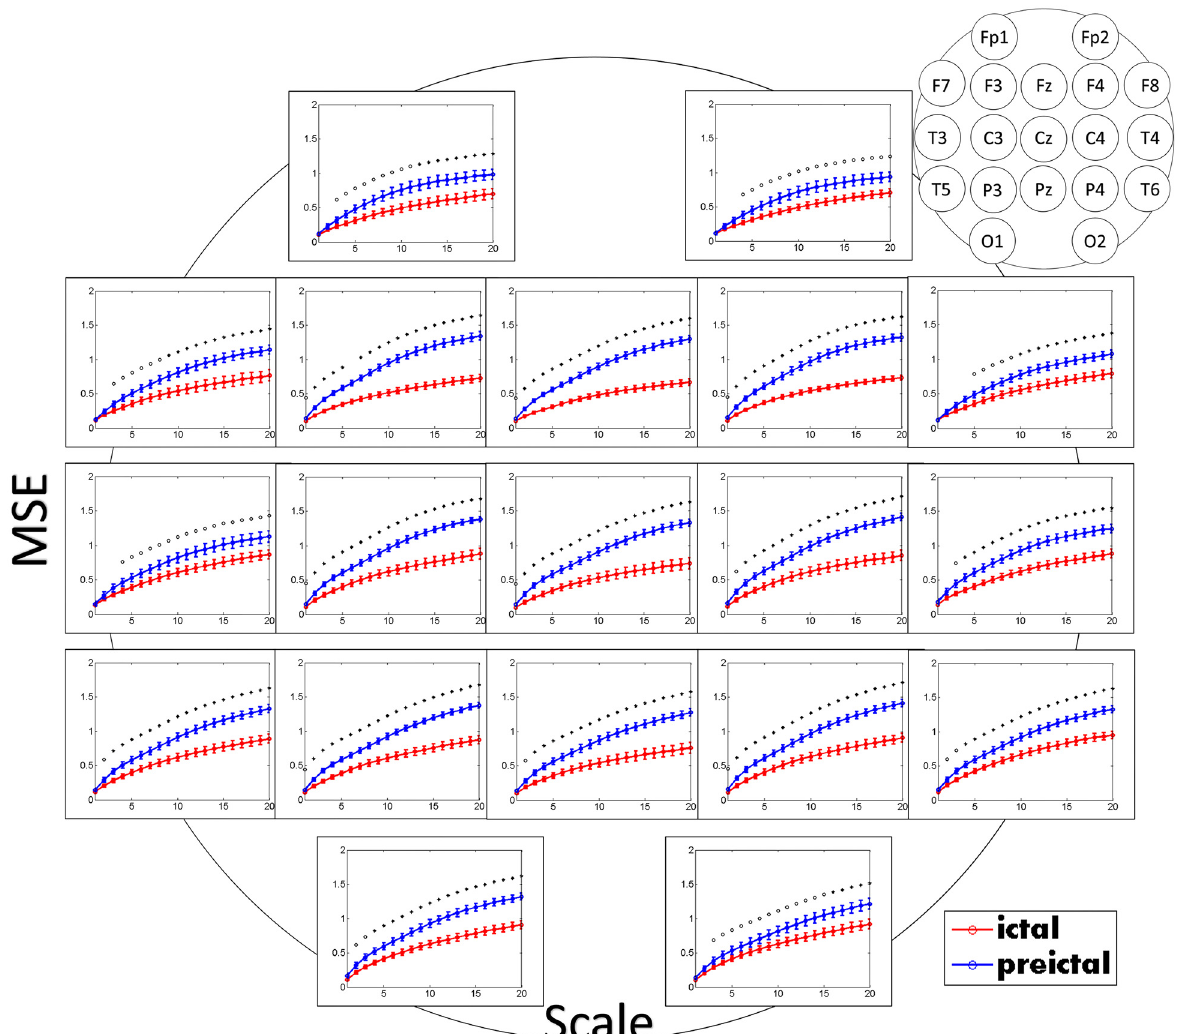
Fig 3. The mean of multi-scale entropy of pre-ictal and ictal states in all patients with sampling frequency of 1000 Hz. Pre-ictal state was represented by the blue line with dots and ictal state was represented by the red line with triangles. The x-axis represented the scale factor and the y-axis represented the multi-scale entropy. The error bars were standard errors. * p < 0.01; o p < 0.05.